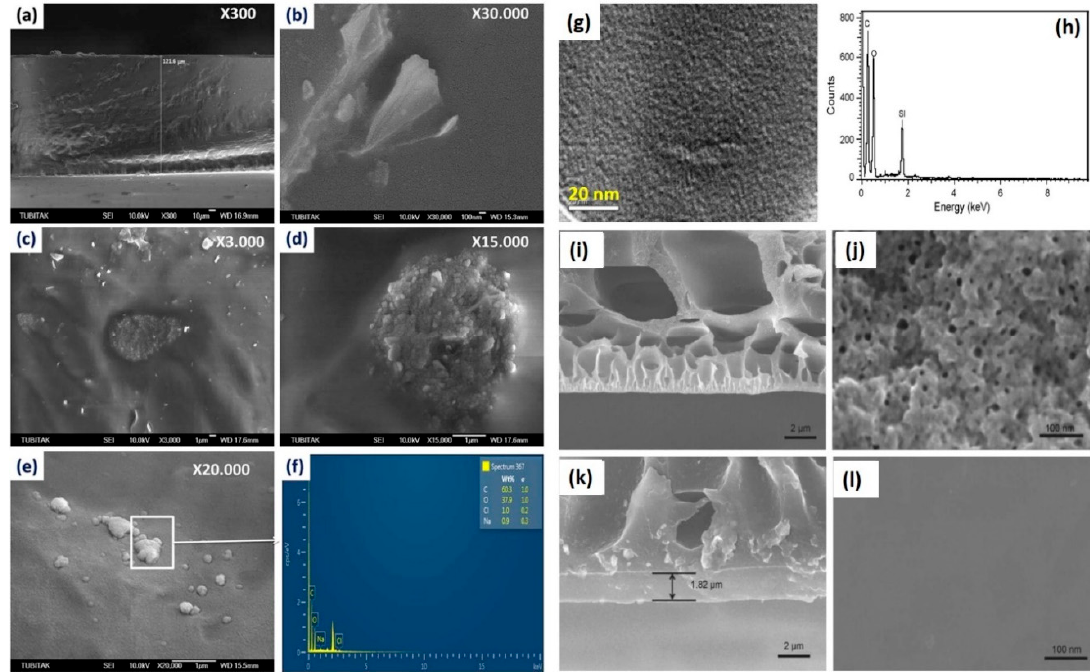
Figure 12. Cross-sectional SEM micrographs of the ( a ) pristine, ( b ) 2 wt% GNPs-PEBA, and ( c , d ) 5 wt% GNPs-PEBA; ( e ) surface micrograph of 2 wt% GNPs-PEBA (after desalination); and ( f ) EDX result of 2 wt% GNPs-PEBA membranes. Reprinted with permission from [121]. Copyright 2017 Elsevier B.V. ( g ) TEM image and ( h ) EDS spectra of the hybrid PVA-MA-silica membrane containing 20 wt% MA and 10 wt% SiO 2 with respect to PVA. Reprinted with permission from [46]. Copyright 2011